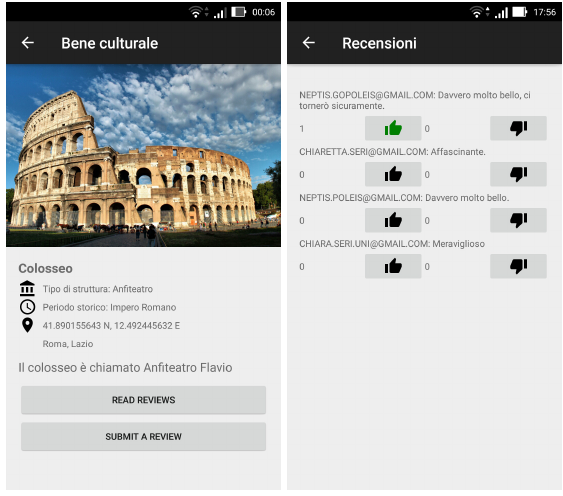
Figure 5. Cultural advisor mini-game